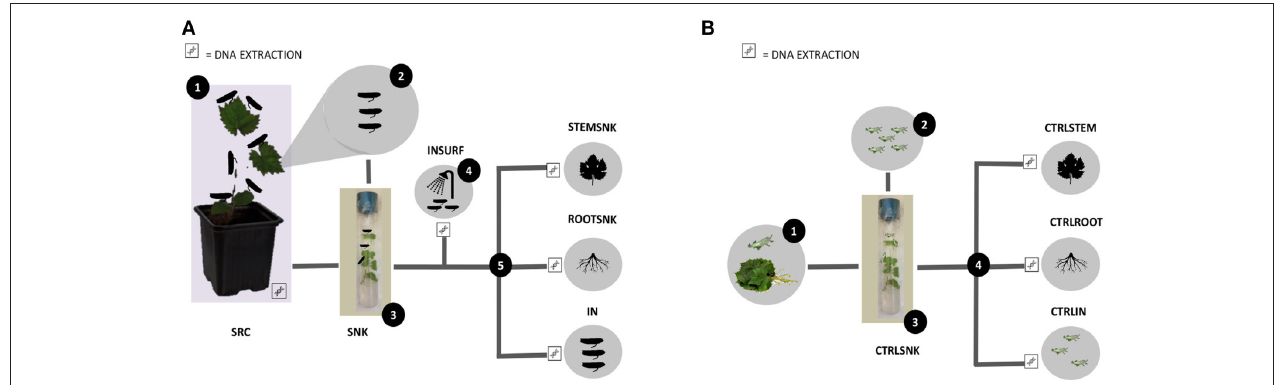
FIGURE 1 | Experimental design. (A) Set up of endophyte transmission experiments through Scaphoideus titanus —Tests. (1) Source plants (SRC) were infested with insects (IN); (2) insects were placed on sink plants (SNK); (3) insects and sink plants were incubated; (4) surfaces of insects were washed (INSRUF); (5) insects, roots (ROOTSNK), and stems (STEMSNK) of sink plants were separated. Surface sterilization was performed before each DNA extraction step. (B) Set up of endophyte transmission experiments through S. titanus —Controls. (1) Control insects (CTRLIN) were left to hatch on grapevine trunks; (2) control insects were placed in control sink plants (CTRLSNK); (3) control insects and control sink plants were incubated, (4) control insects, control roots (CTRLROOT), and control stems (CTRLSTEM) were separated. Surface sterilization was performed before each DNA extraction step.